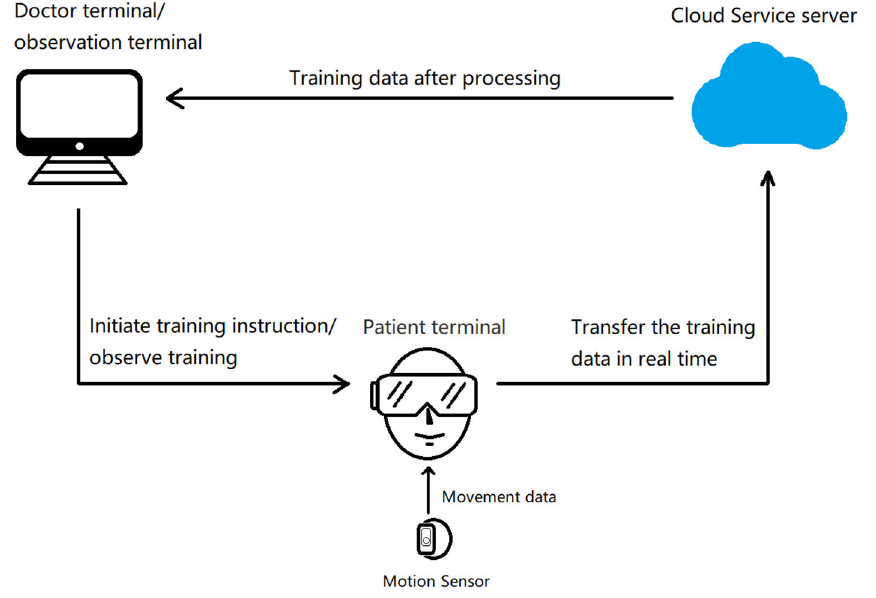
Figure 2. Product structure diagram for immersive virtual reality (IVR).